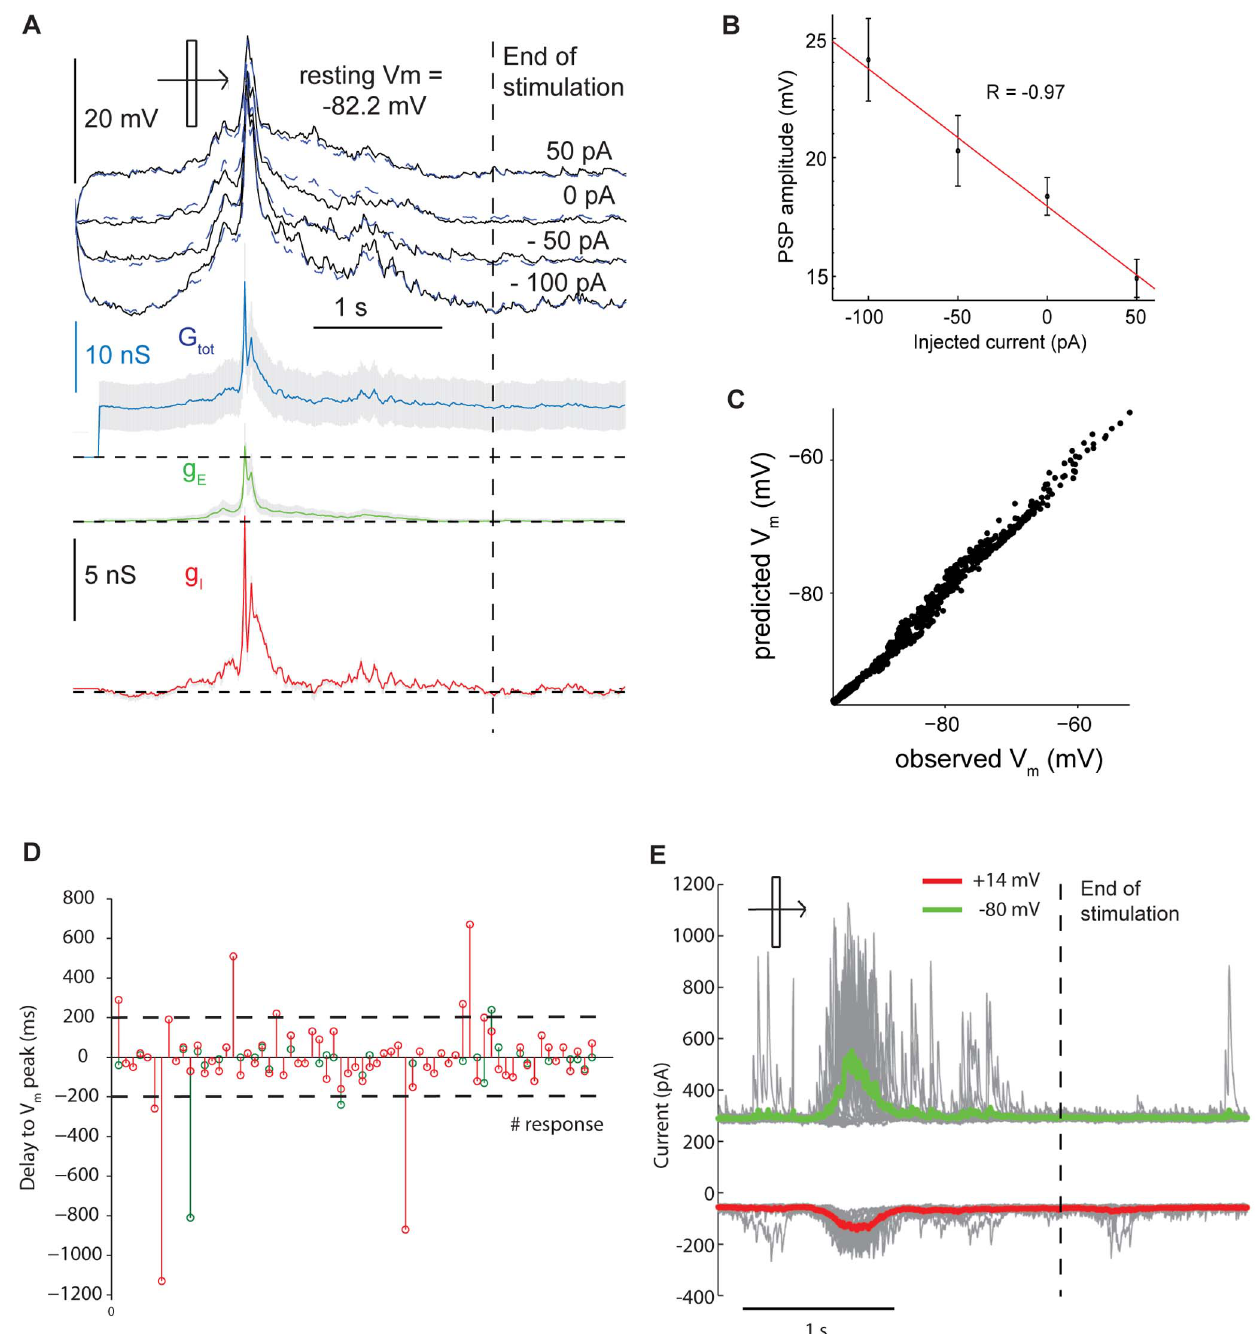
Figure 2. Estimate of visually-driven excitatory and inhibitory synaptic conductances. A . Visual responses to an optimally oriented moving light bar of a 4RSN recorded under 1 mM QX314 while injecting different steady currents. The black, continuous line are the recorded V m values, whereas the blue, dashed trace shows the reconstructed V m values obtained by inserting back the estimated g E and g I values into the fundamental membrane equation. The instantaneous total synaptic conductance is calculated based on the instantaneous slope of the current- voltage relation (G tot , blue). The time-dependent excitatory (g E , green) and inhibitory (g I , red) conductances are plotted below. Gray traces represent the 95% confidence intervals obtained by bootstrapping of the data (see Methods). Conductance measurements began after the response to the injected current was at steady state (after 200 ms). Resting conductances were calculated in absence of visual stimulation (dashed line: stimulus end). B . Visually-driven PSPs vary linearly with the injected current. Plot showing the linearity of the relationship between the amplitude of the visually- driven PSP response and the value of the injected current (r= 2 0.97) for a 4RSN (this plot refers to the example shown in Figure 2 of the Main Text). Means 6 standard erros are shown. The median of the correlation coefficients for all the recorded neurons was 2 0.94 (25 th –75 th percentiles: 2 0.88 2 2 0.99). C . Plot of the recorded vs reconstructed V m values obtained by inserting back the estimated g E and g I into the membrane equation. The linearity of the cell and the accuracy of the V m reconstruction is shown by the fact that data points align along the line of steepness 1 and intercept 0 in the plot. D . Temporal intervals between the peaks of g E (green) and g I (red) and that of the V m response. For each cell, values for both contralateral and ipislateral responses are plotted. Note that in the vast majority of cases the conductance values have been obtained in close proximity of the V m